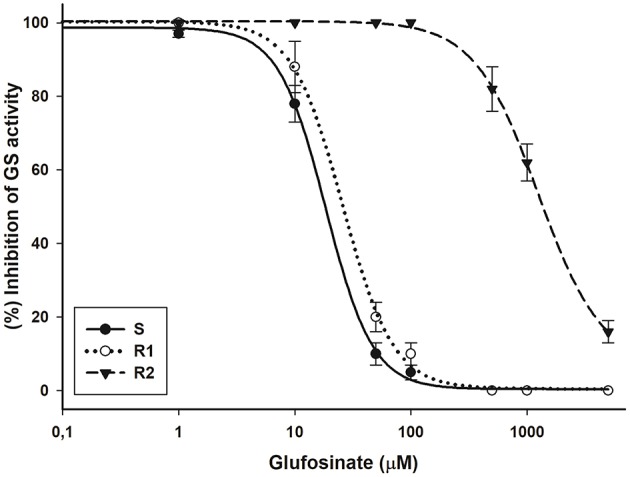
Glutamine synthetase (GS) inhibition by glufosinate in bipyridylium-resistant Epilobium ciliatum biotypes. The equations of log–logistic curves to estimates the I50 values are: S: Y= 0.39+{(98.64–0.39)/[1+ (dose/I50)2.14]},(R2 = 0.99); R1: Y = 0.50+{(100.30–0.50)/[1+(dose/I50)1.99]},(R2 = 0.99); R2: Y=6.55+{(100.39–6.55)/[1+(dose/I50)1.57]}, (R2 = 0.99). Vertical bars are ± the standard errors of the mean (n = 3).